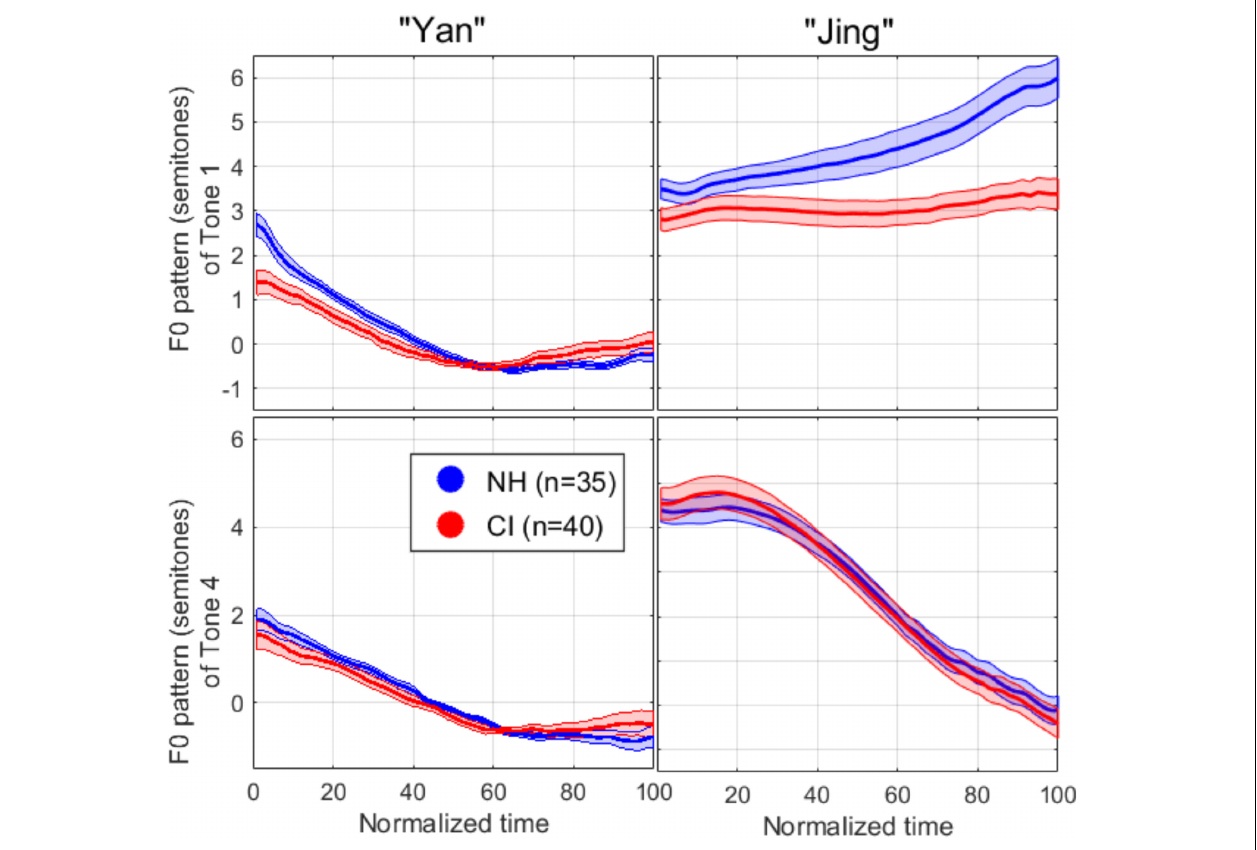
FIGURE 5 | F0 pattern extracted for each syllable in each tone, with normalized duration (extracted with a 20-dB cutoff from the intensity peak) and normalized in its scale by expressing F0 in semitones relative to the mean over the first syllable. Lines represent the mean over all participants in a given group and areas represent one standard error of the